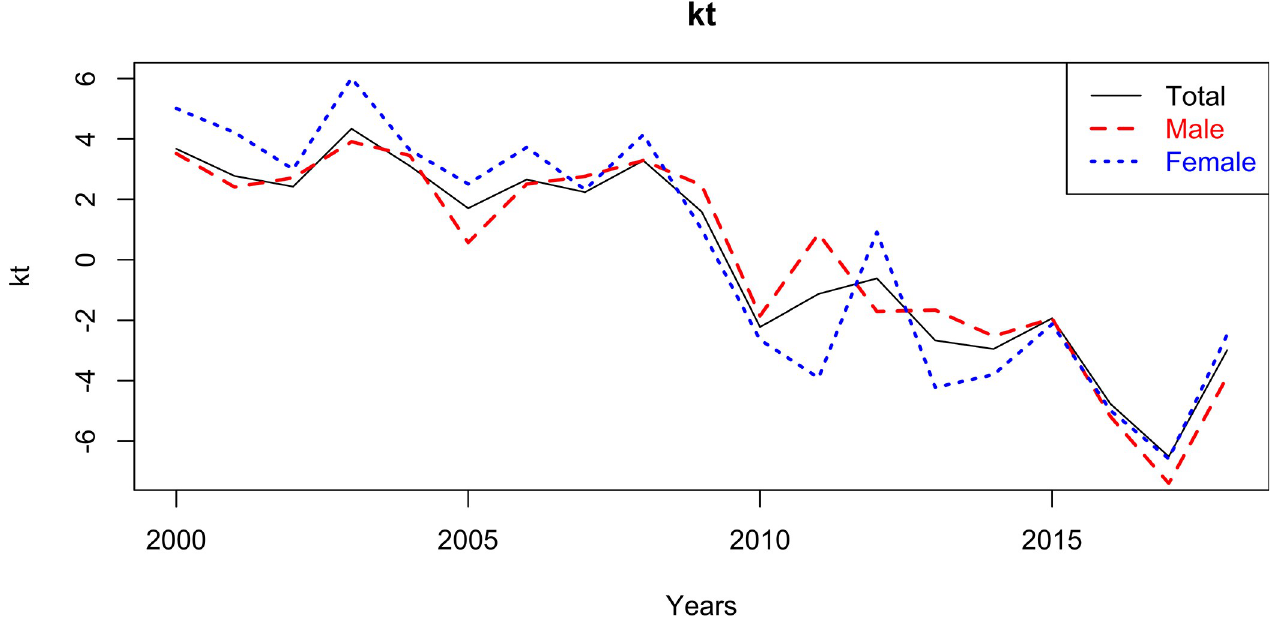
Fig 12. Adjusted kt estimate, from the Lee-Carter model for males, females and both genders (2000–2018).